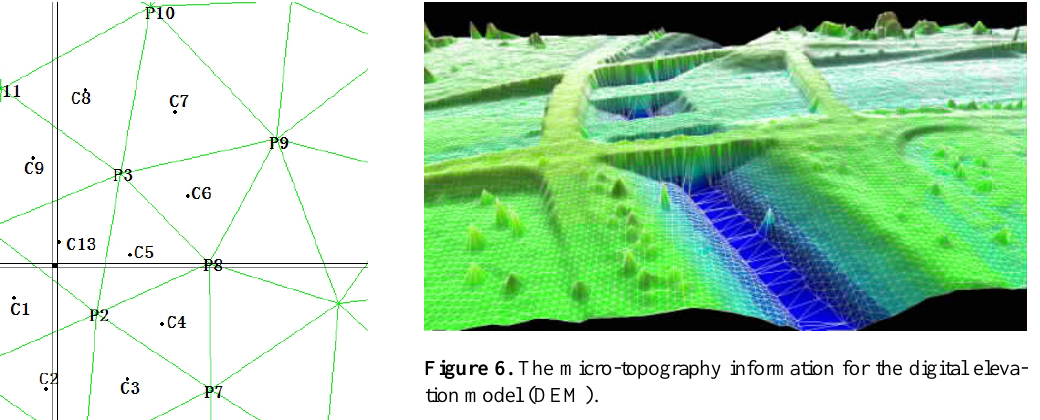
tion. For the cell located at row I and column J of the DEM grid, we can decide the location of the cell by the spatial co- ordinate of the central point. If a DEM grid cell (the black square) is inside P1P2P3, the following methods can be used to choose the nodes for water-level interpolation.